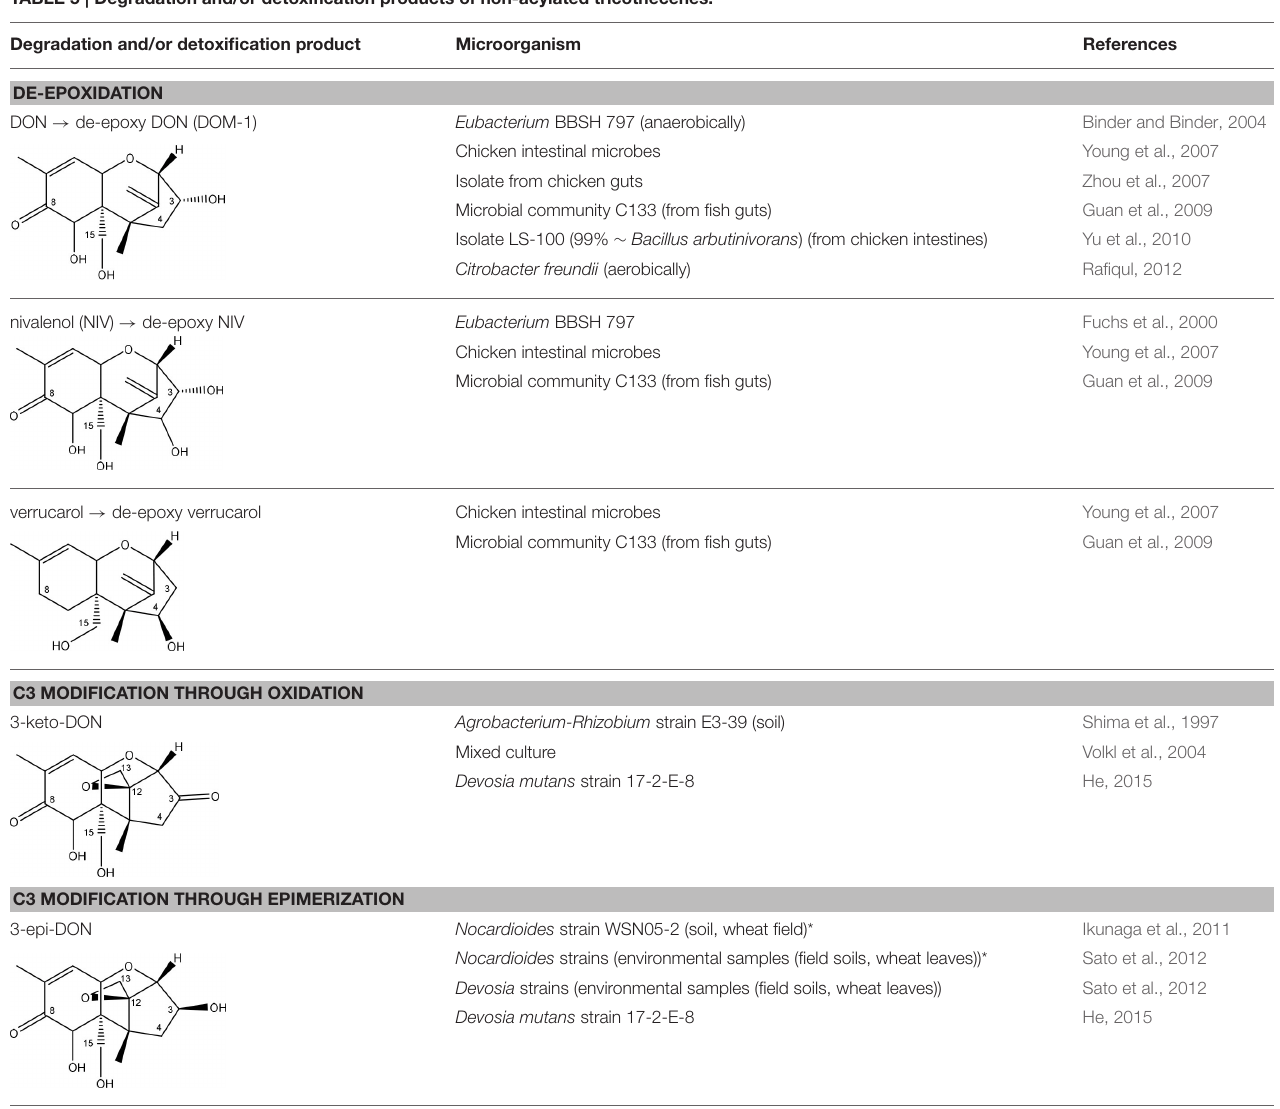
TABLE 5 | Degradation and/or detoxification products of non-acylated